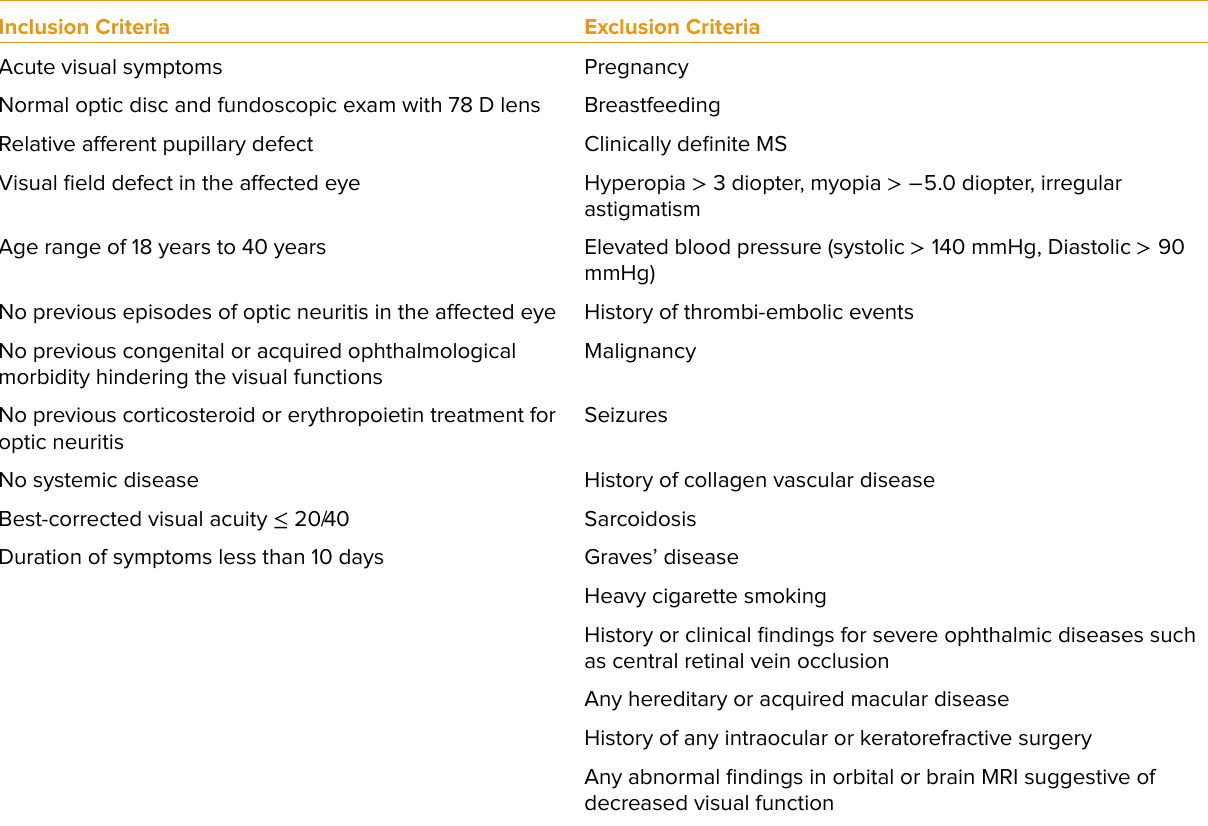
Table 1. Eligibility